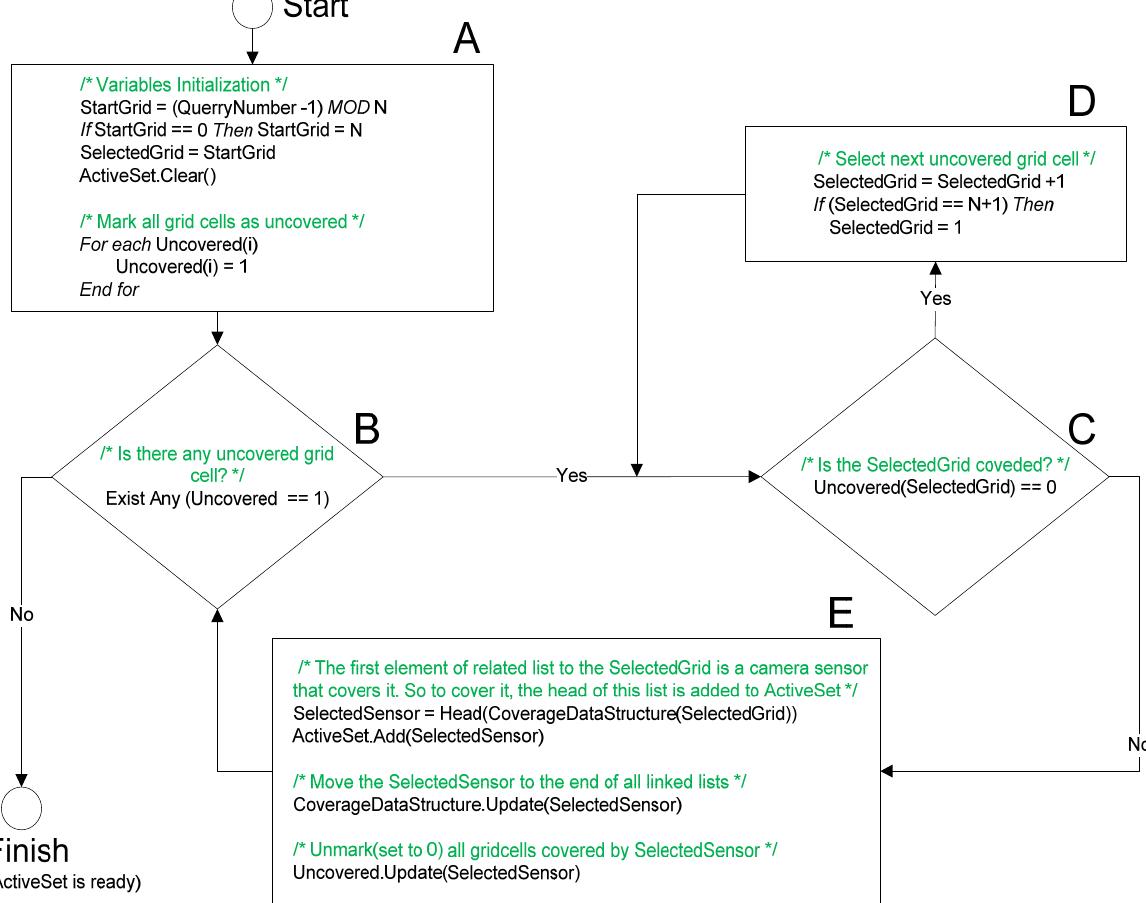
Figure 6. Flowchart of fire camera node selection